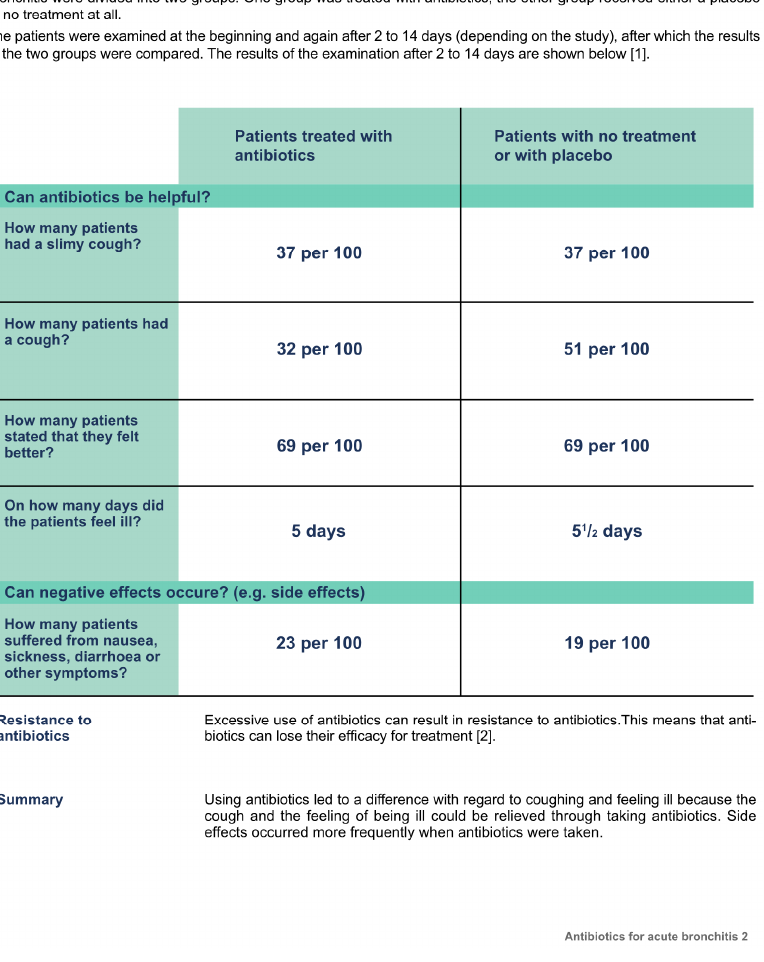
Figure 1. Fact box that presented treatment effects as natural frequencies.